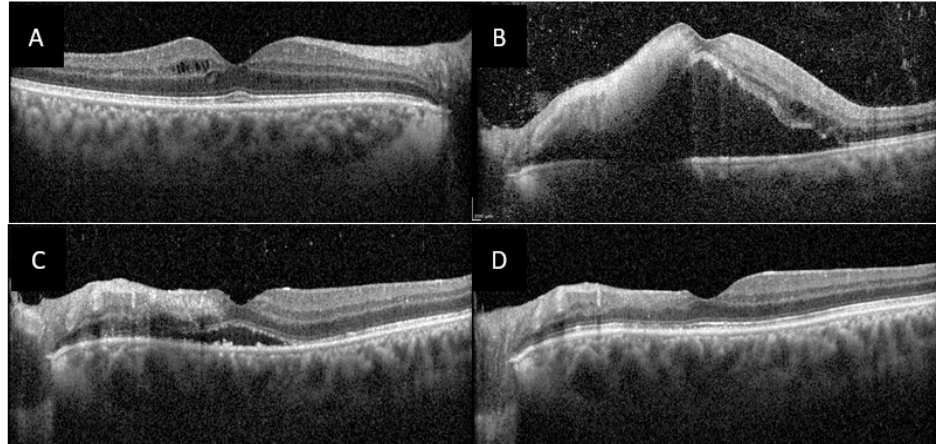
Figure 4. Optical coherence tomography (OCT) of both macula of case 2 patient. ( A ), OCT of the right macula showing a few cysts of intraretinal edema. ( B ), OCT of the left macula showing a large serous retinal detachment, a hyperreflective nodule in the inner retinal layers, intraretinal edema and numerous hyperreflective dots in the vitreous. ( C ), OCT of the left macula at 1-month follow-up showing partial regression of subretinal fluid. ( D ) OCT of the left macula at 3 months follow-up showing complete regression of macular edema, and atrophy of internal retina in place of the hyperreflective nodule.